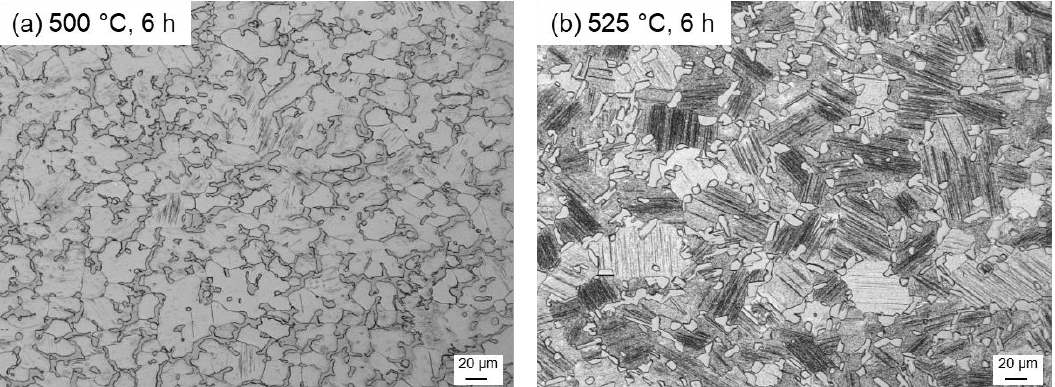
Figure 6. Optical micrographs of the twin-roll cast and annealed WZ73 alloy at ( a ) 500 °C, 6 h and ( b ) 525 °C, 6 h after cooling in air (upper area of the strip cross section).